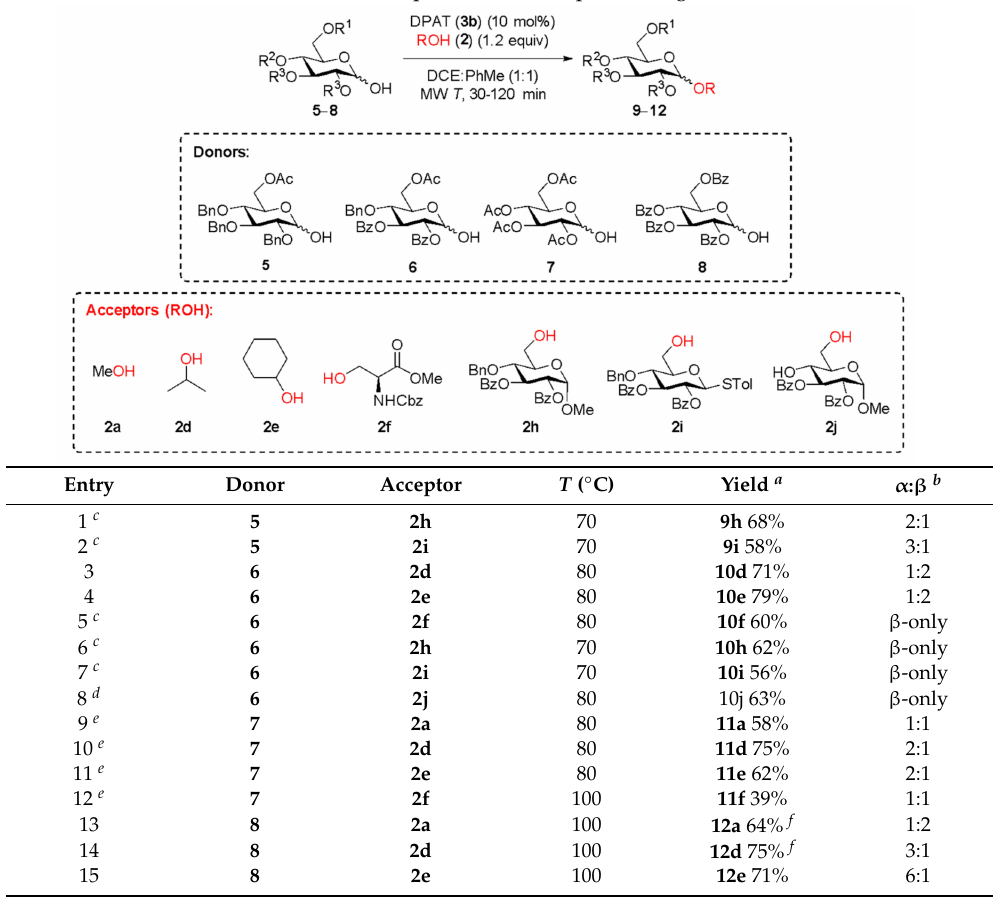
Table 3. Reaction scope with various-protected